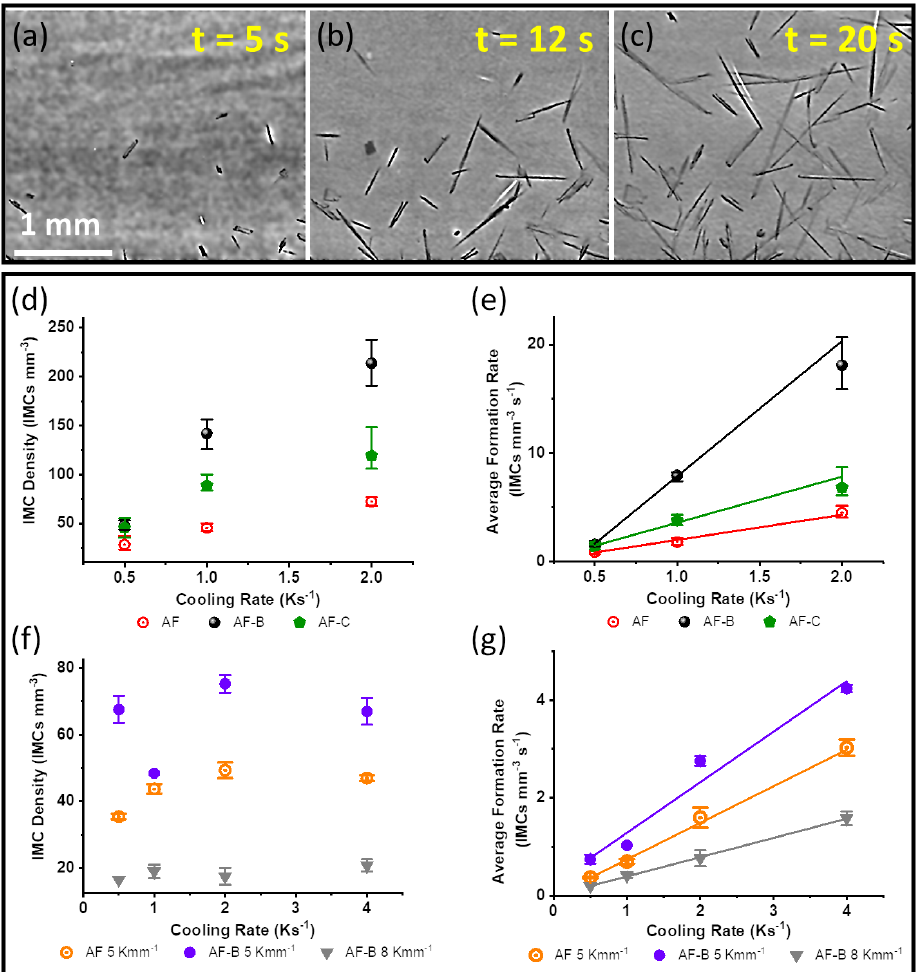
Figure 6. ( a – c ) An example radiograph sequence showing the formation of primary Al 13 Fe 4 in a TiB 2 inoculated Al-3wt.%Fe alloy during directional solidification at 2Ks − 1 and 5Kmm − 1 . Each image was obtained by subtracting frame f n − 15 from frame f n . ( d ) IMC number density and ( e ) average formation rate in isothermal conditions (AF: Al-3wt.%Fe base alloy; AF-B: TiB 2 inoculated; AF-C: TiC inoculated). ( f ) IMC number density and ( g ) average formation rate in directional conditions. The solid lines in ( e , g ) represent a linear best-fit of the average formation rate as a function of cooling rate [15] (Reprinted with permission from [15]. Copyright 2020